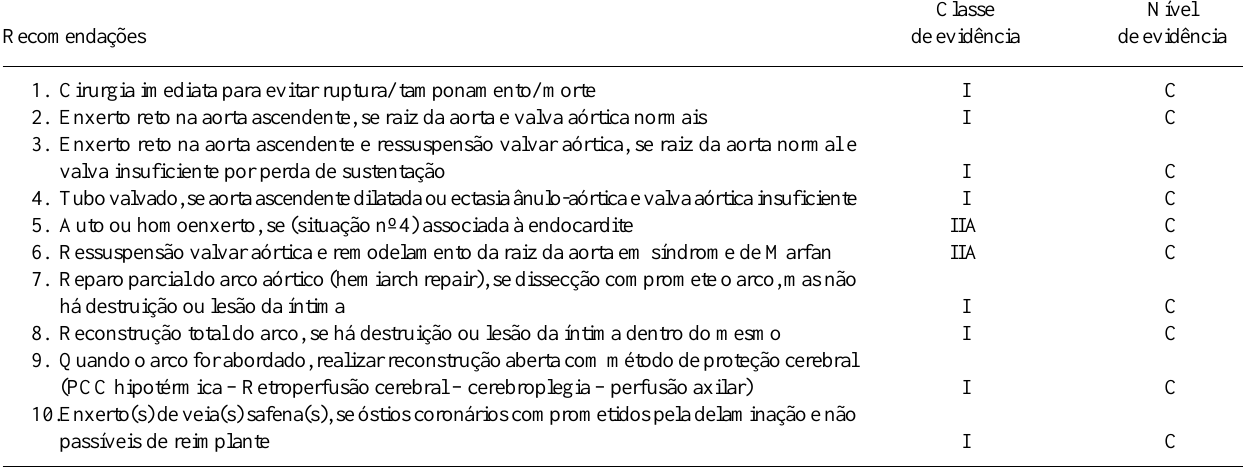
Tabela 1. Recomendações para o tratamento das dissecções agudas tipo A.